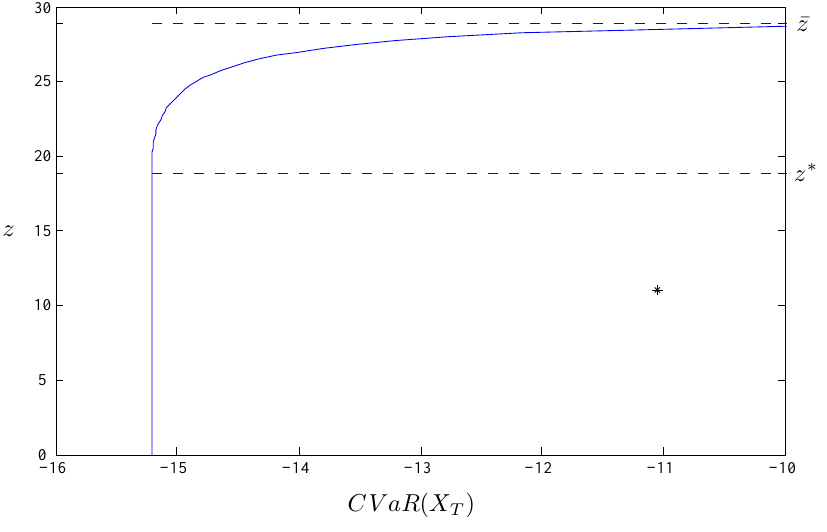
Figure 1. Efficient frontier for mean-CVaR portfolio